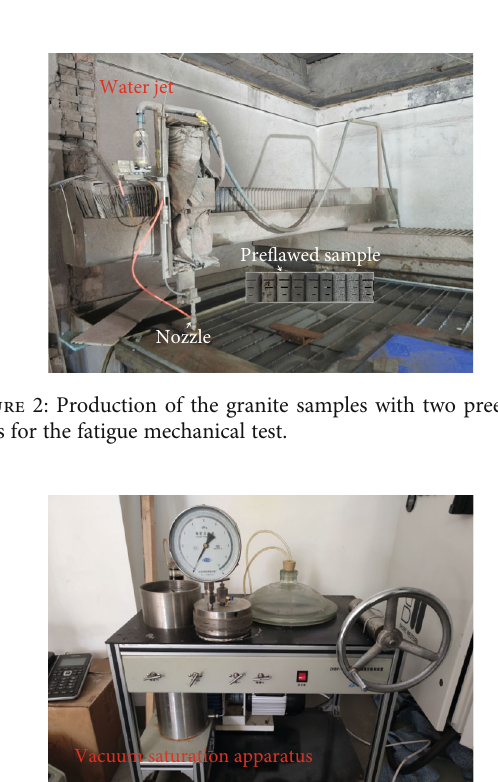
Figure 1: Description of the rock mass structural characteristics in the eastern open pit slope of Beizhan iron mine. Obvious rock bridge structure can be observed from the outcrop.